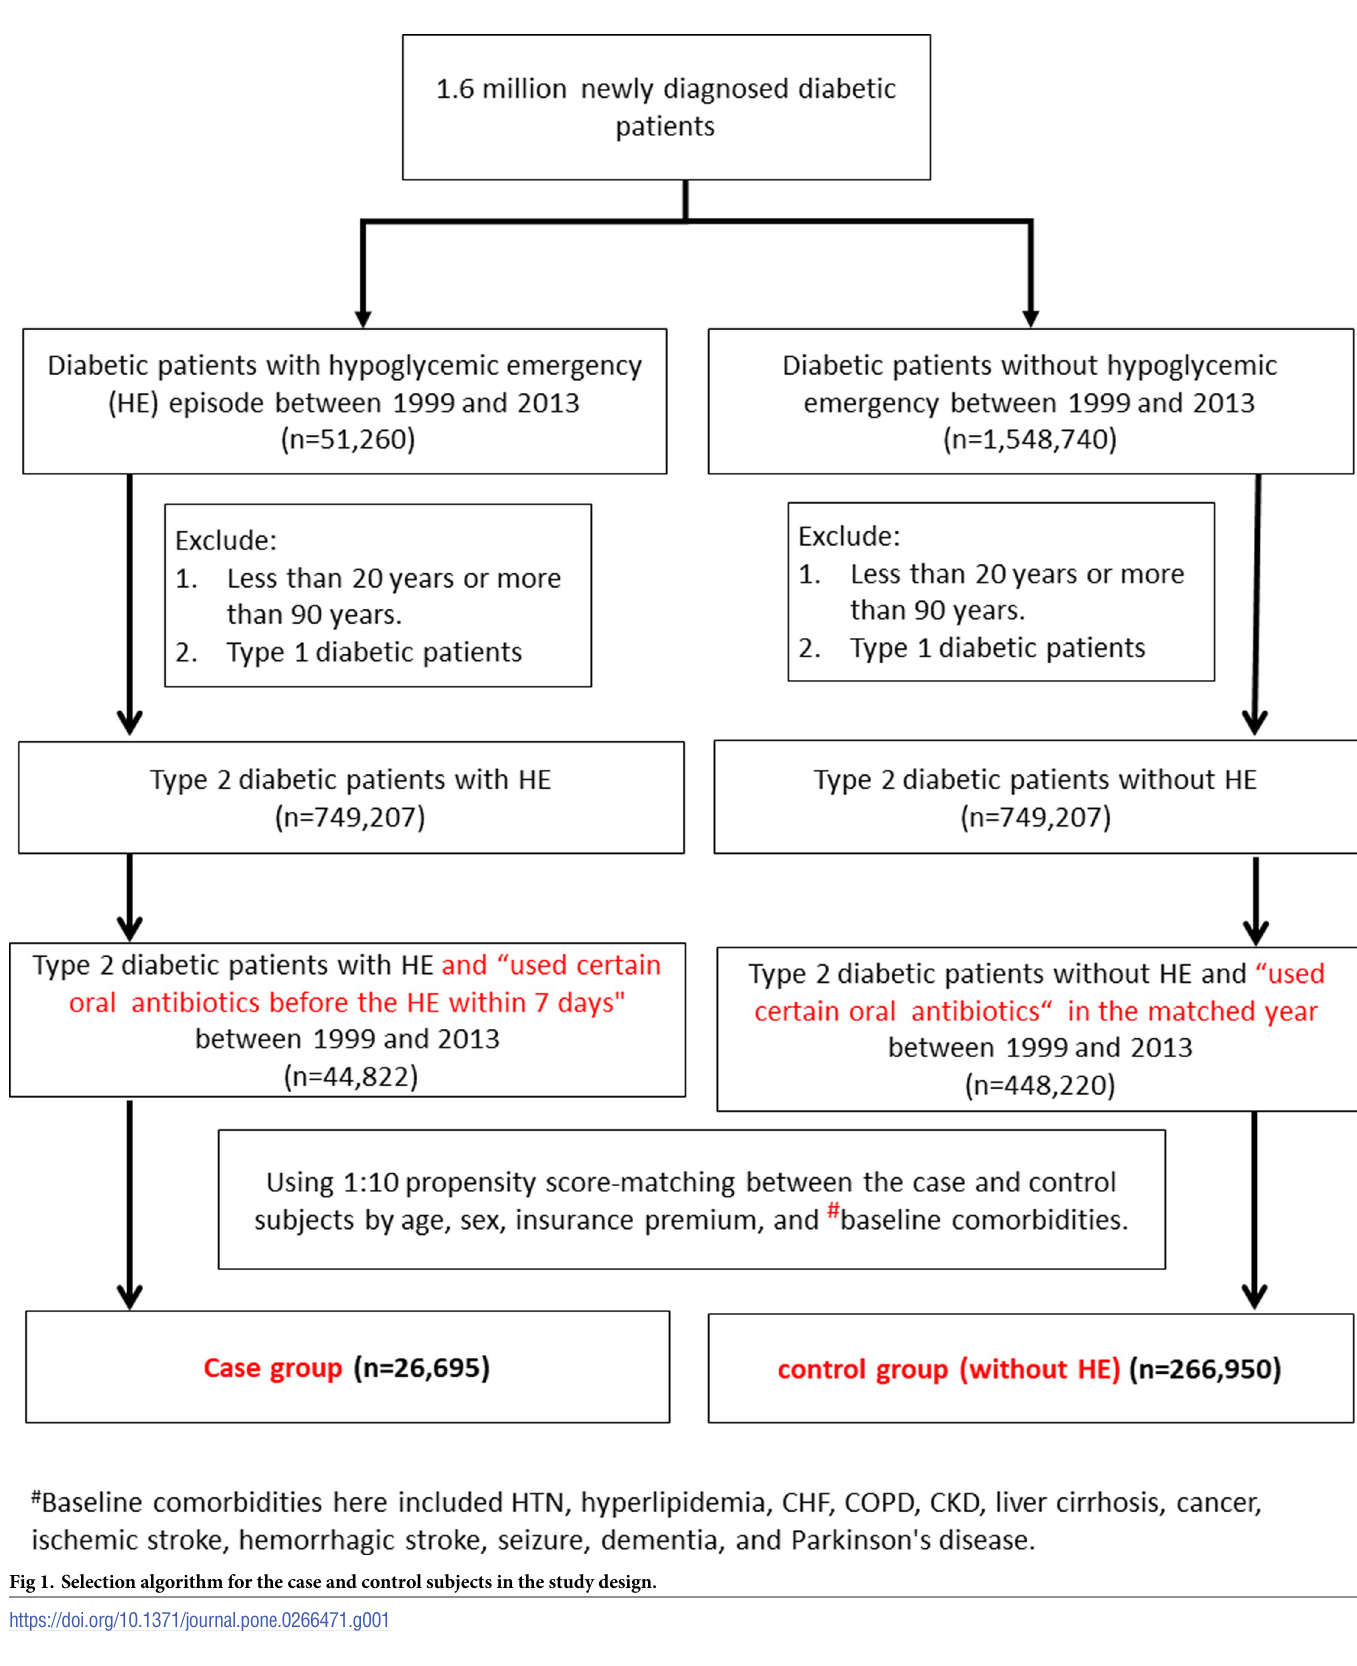
PLOS ONE | https://doi.org/10.1371/journal.pone.0266471 April 4,